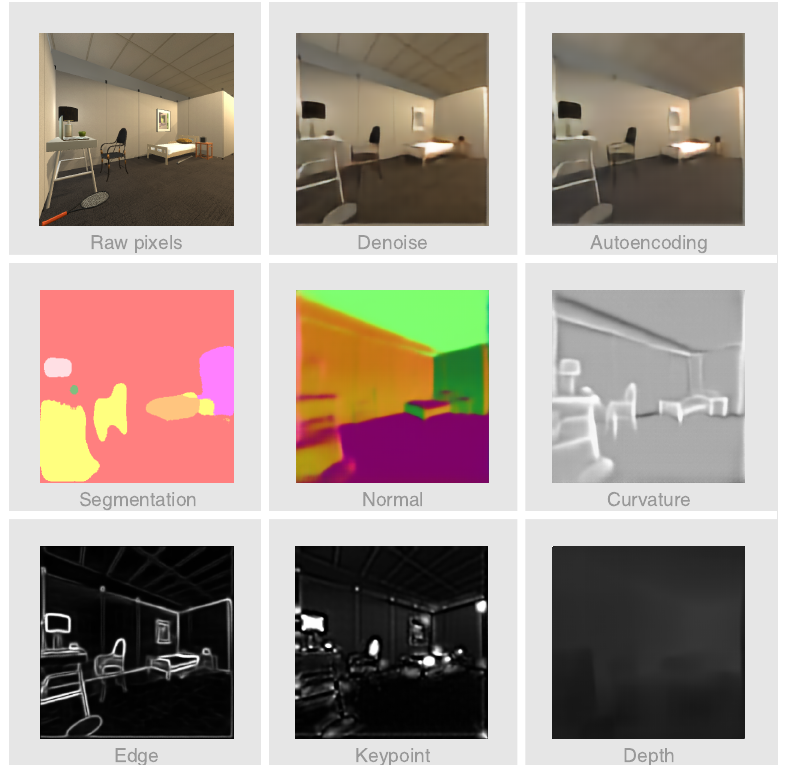
Figure 4. State representations with visual priors. Humans tend to observe the world with prior knowledge, e.g., it is more effective to use objects as the basic unit for understanding the world rather than the pixel. These representations contain higher-level prior knowledge about the environment, which is conducive to the learning efficiency and generalization of